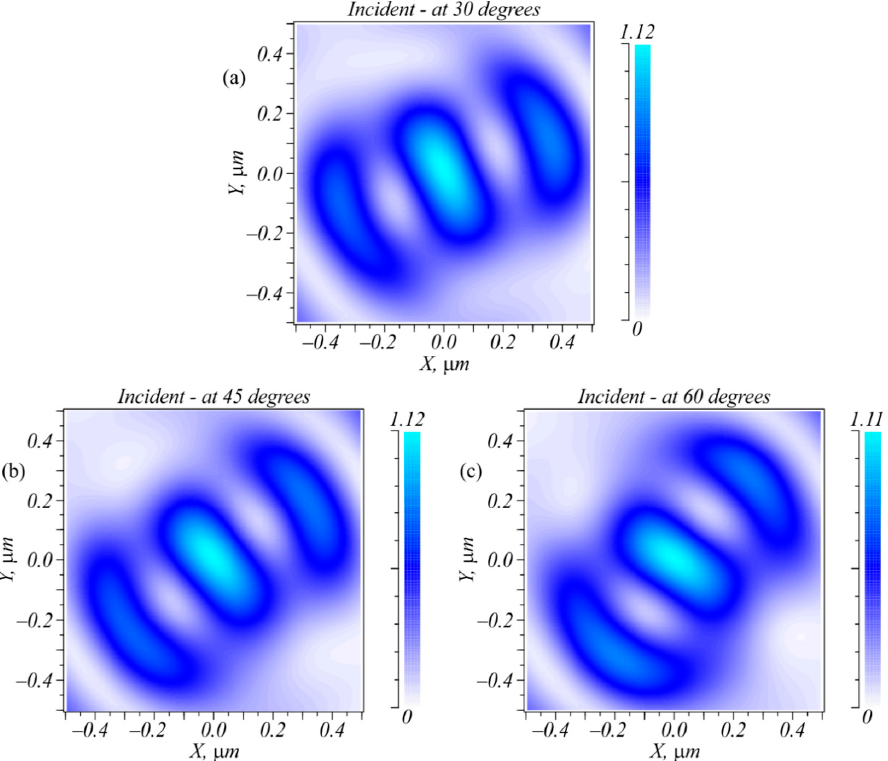
Figure 4. Intensity distribution at the focal plane for the incident linear polarization rotated at angle φ : 30° ( a ); 45° ( b ); 60° ( c ).